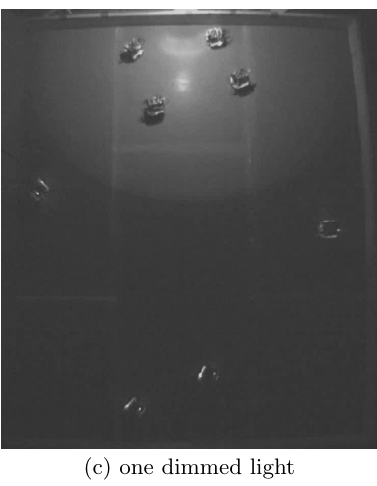
Figure 7: Typical situations observed during the ex- periment for different light settings.